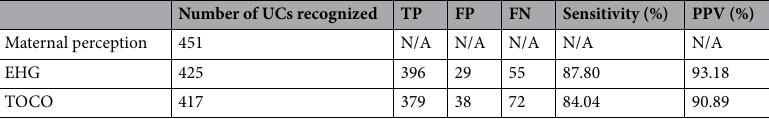
Table 1. UC recognition results. N/A: not available.